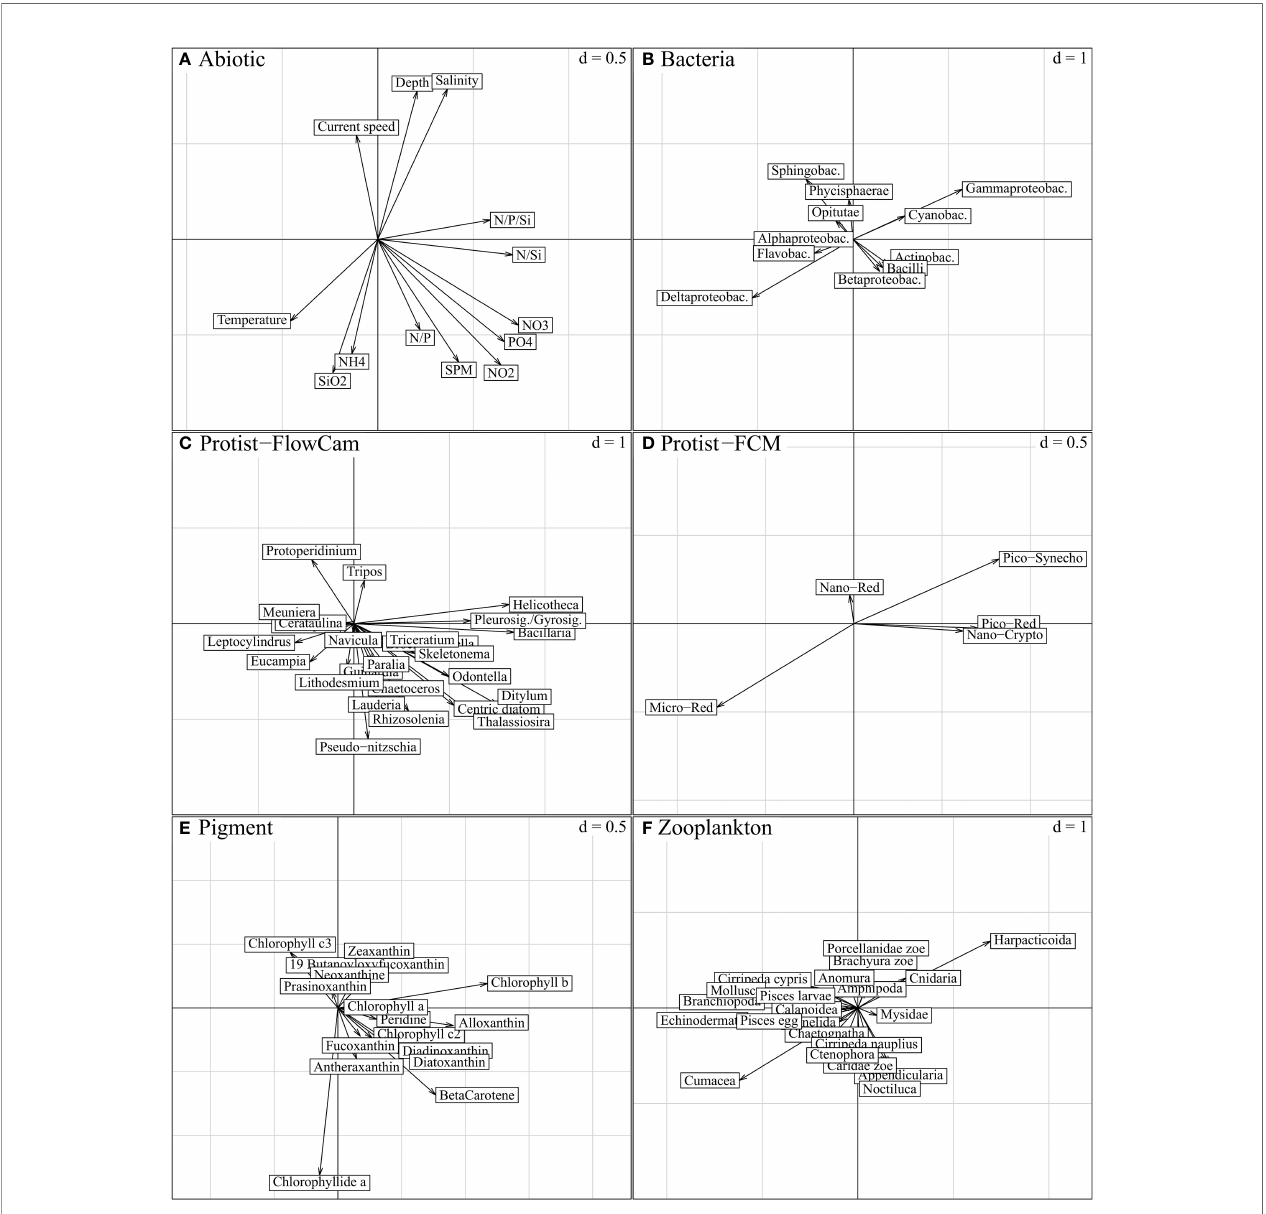
FIGURE 7 | STATIS compromise, projection of descriptors per ecosystem component on compromise axis 1 (horizontal) and axis 2 (vertical); “ d ” indicates the grey grid scale, i.e. the axis unit. The variables expressed on these axes characterise the spatial variations in Figure 5B (axis 1; from left to right, east-west gradient) and Figure 5C (axis 2; down-top, nearshore-offshore gradient), respectively. Both axes are characterized by nutrient load variations, physical aspects being more speci fi c to axis 2 (A) . Biotic entities associated to these physico-chemical gradients are best represented by the longest and respectively collinear vectors in (B-F) . As emphasized in Figure 6 ( “ STATIS axes 1-2 ” ), most ecosystem components are expressed on both axes, except Protist-FCM with lower expression on the second